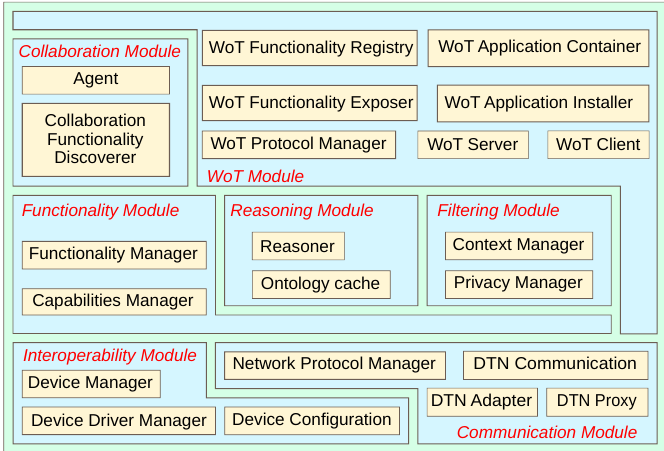
Figure 4. Architecture of an